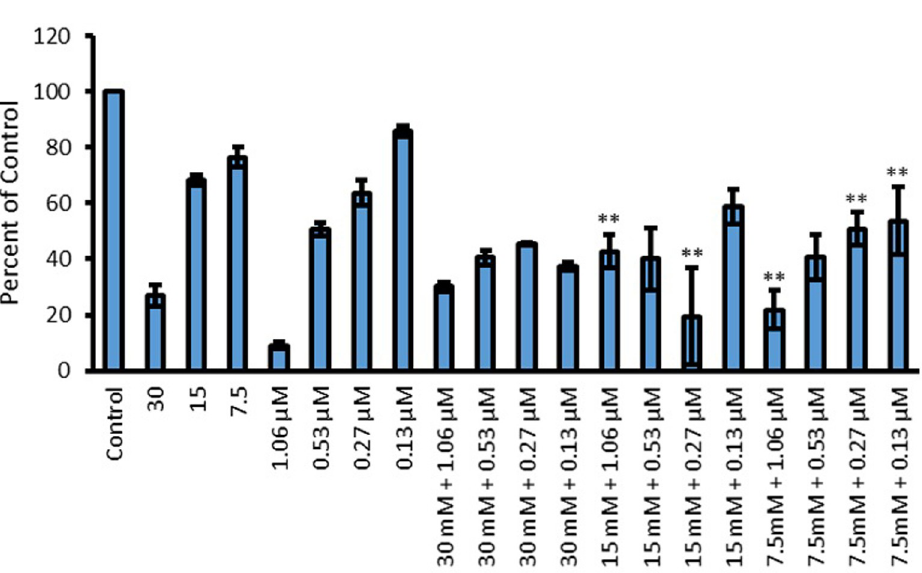
Fig 12. Effect of L-Glu, Cip and L-Glu and Cip combinations on the production of pyoverdine by P . aeruginosa . Y-axis shows concentration of pyoverdine as a percentage of untreated, when treated with 30, 15 and 7.5 mM L-Glu, 1.06, 0.53, 0.27 and 0.13 μ M Cip and their combinations. Significant results are indicated by � or �� , where � represent a significant reduction in pigment production by the amino acid or Cip compared to control and �� represents a significant reduction in pigment production by combinations (AA + Cip) compared to both of the individual corresponding components (p < 0.05 was taken as significant); n = 3.